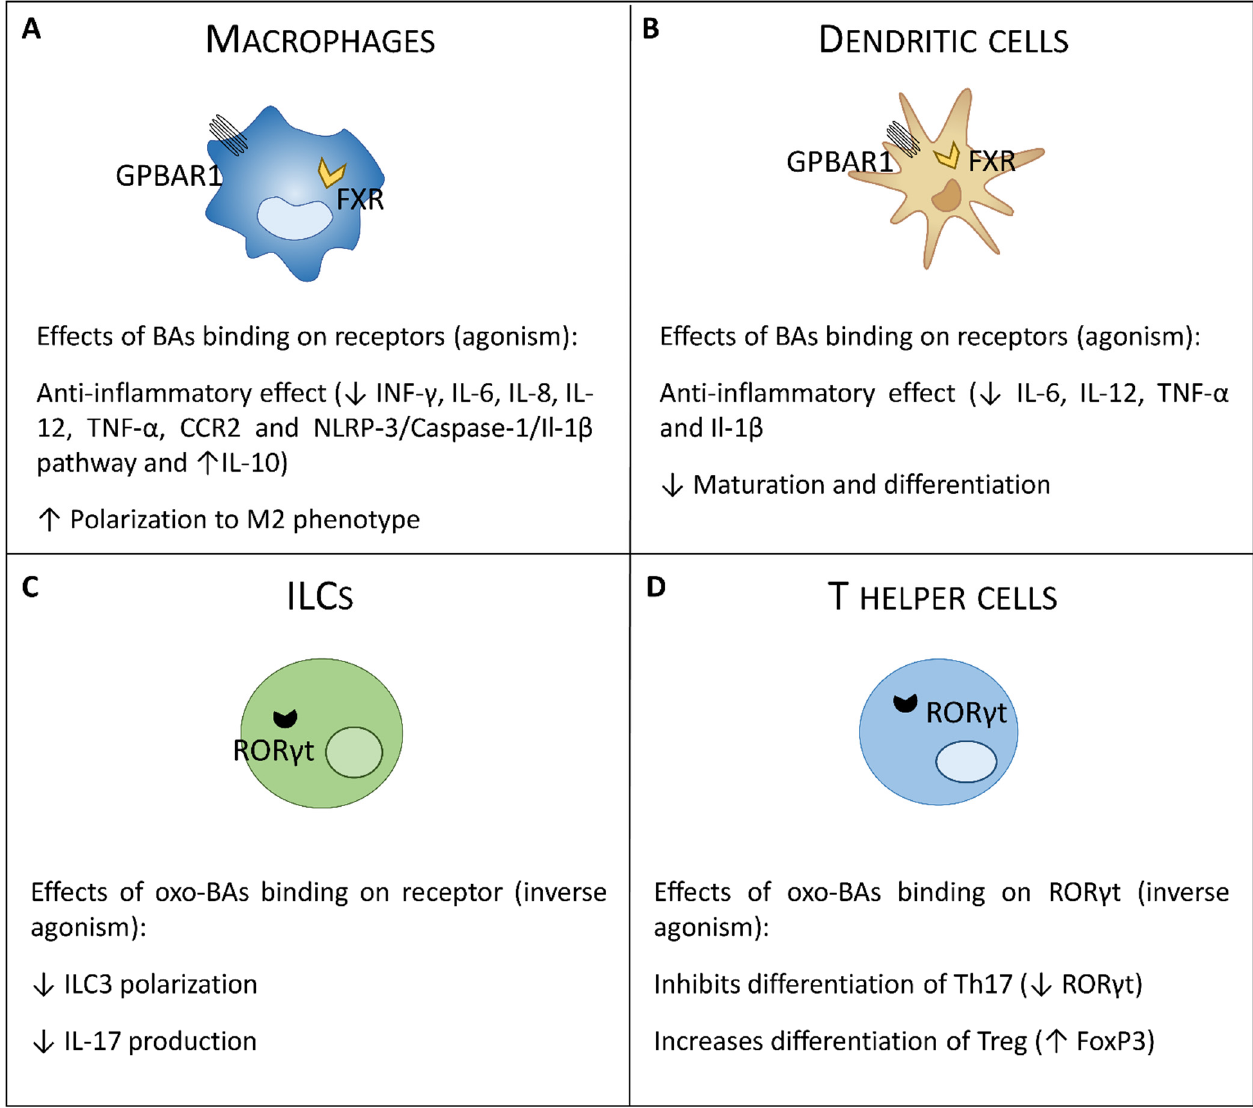
Figure 2. Expression and functional role of G-protein bile acid receptor 1 (GPBAR1), Farnesoid-X-receptor (FXR) and ROR γ t in cells of immunity. Macrophages and dendritic cells (DCs) express GPBAR1 and FXR. T helper cells and ILCs express ROR γ t. ( A ) In macrophages, activation of these receptors by bile acids induces a polarization toward the anti-inflammatory M2 phenotype with an upregulation of IL-10 and a downregulation of the pro-inflammatory cytokines. ( B ) Bile acids, on the other hand, act on the DCs, down-regulating the production of TNF- α and IL-12 and their maturation and differentiation. ( C , D ) Recently, it was shown that oxo-bile acid derivatives, specifically the 3-oxo-LCA, can bind ROR γ t by acting as an inverse agonist, decreasing the production of IL-17 in T helper cells and ILCs by reducing the polarization towards the Th17 and ILC3 subtypes.